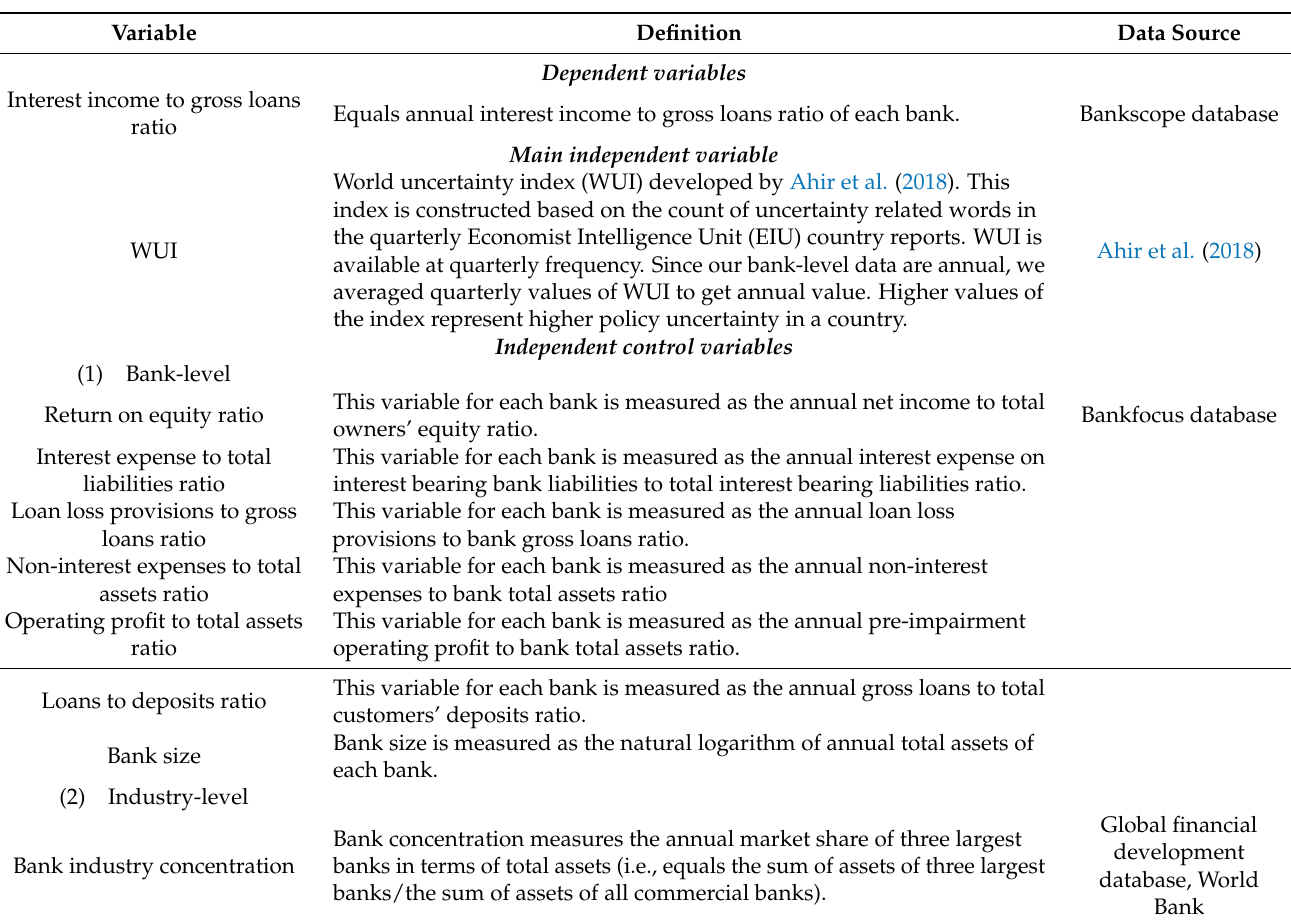
Table 2. Variable